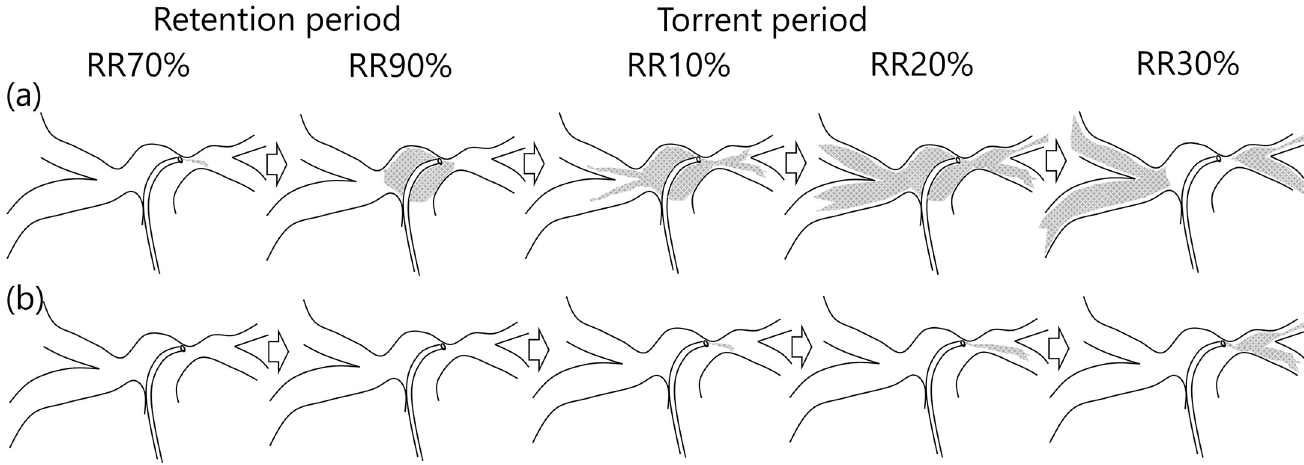
Fig 5. Typical schematic demonstration of angiographic contrast agent injected into the pulmonary trunk through a catheter. (a) If contrast agent is injected over 50–90% of the R-R interval in the retention period, the agent can be retained and well mixed during the retention period, then simultaneously discharged to both pulmonary branches over 10% of the R-R interval in the torrent period. (b) However, if the contrast is injected during 0–50% or 90–100% of the R-R interval in the retention period, the contrast agent flows preferentially to the unilateral pulmonary branch without retention or mixing.